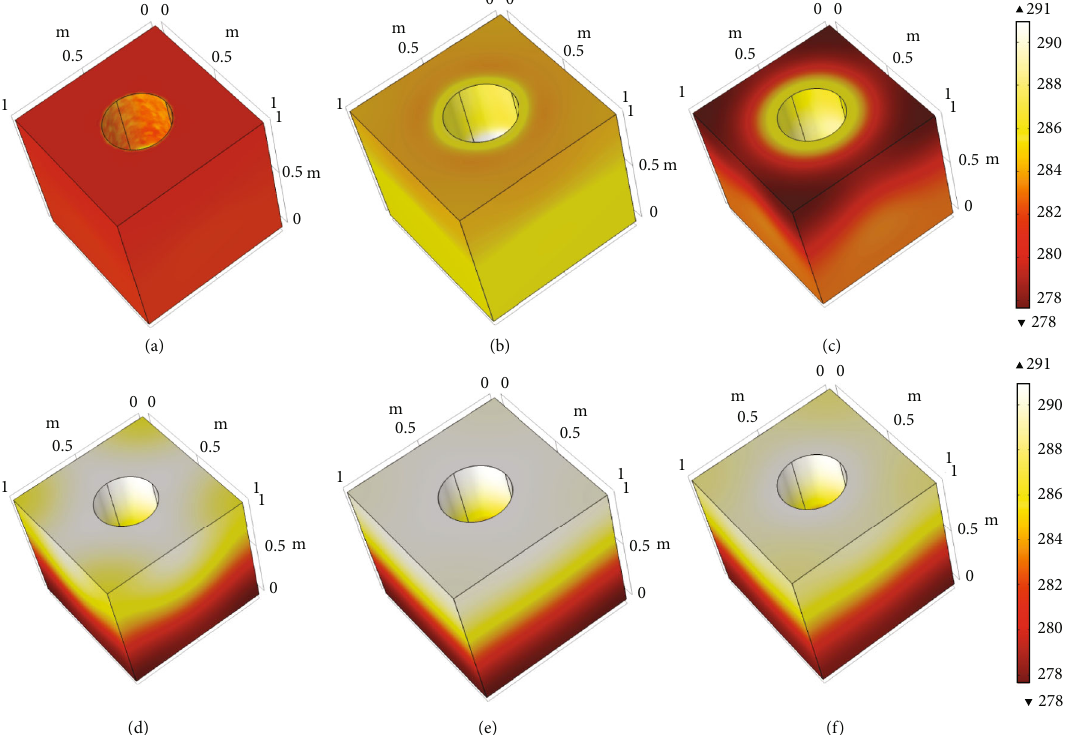
Figure 6: Thermal fi eld in the homogeneous coal rock: (a) t = 0 : 1 s, (b) t = 1 × 10 3 s, (c) t = 1 × 10 4 s, (d) t = 1 × 10 5 s, (e) t = 1 × 10 6 s, and (f) t = 1 × 10 7 s.